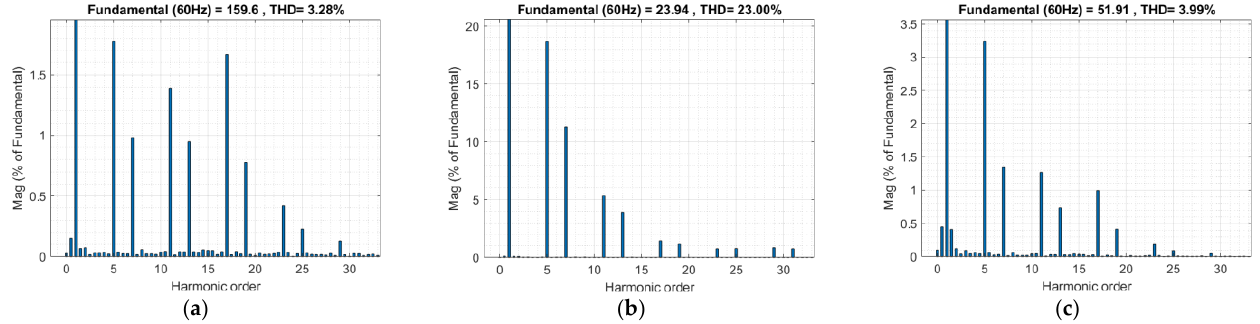
Figure 10. Total harmonic distortion (THD) of the PCC voltage ( a ), non-linear load ( b ), and DG current ( c ).